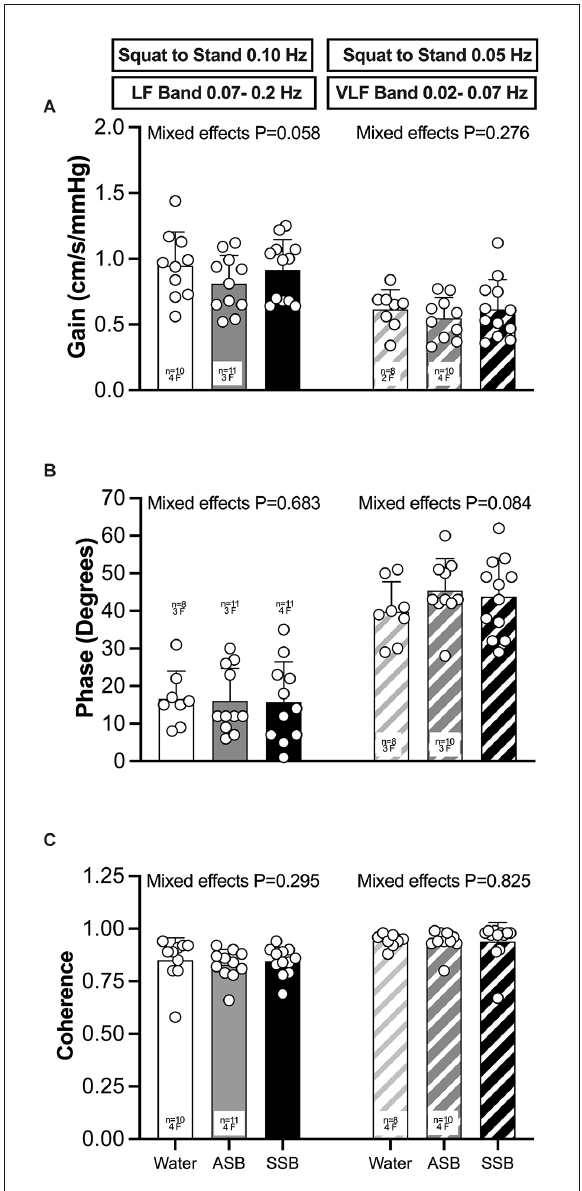
FIGURE3 Dynamic cerebral autoregulation mean (bars) ± standard deviation and individual (circles) responses of the middle cerebral artery for gain (A) , phase (B) , and coherence (C) for both squat-to-stand frequencies (0.10 Hz and 0.05 Hz). Mixed effects models were used to compare data between conditions. If a mixed effects model revealed a significant effect, a post-hoc Holm-Sidak multiple comparisons test was used to determine where differences existed. Values are presented as the 5 min mean (bars) ± standard deviation and individual responses (circles). n = 12, four females unless otherwise noted. Missing data occurred due to exclusion due to noise during transfer function analysis. ASB, artificially-sweetened beverage; SSB, sugar-sweetened beverage.